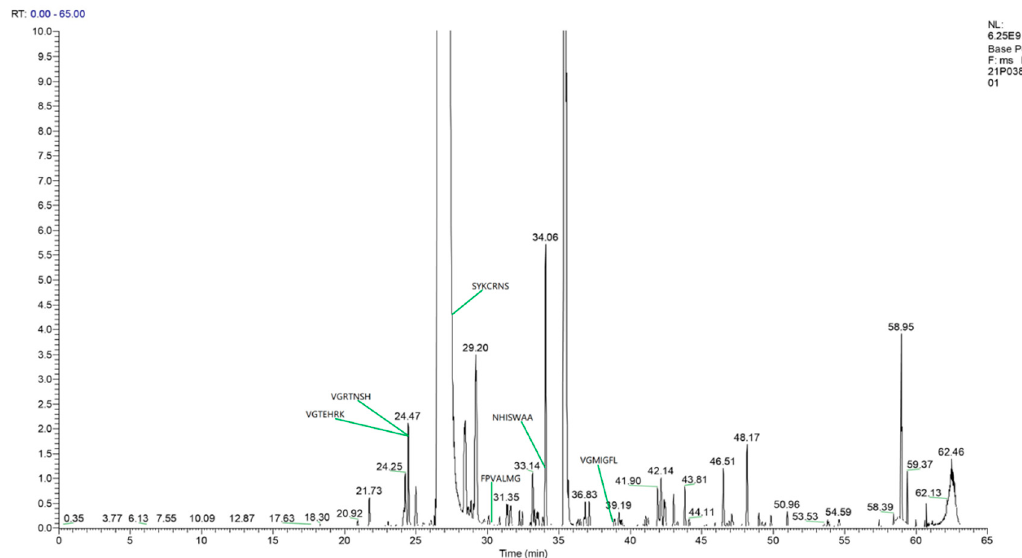
Figure 4. Total ion chromatogram of peptides from oyster hydrolysates (UEC4-1).